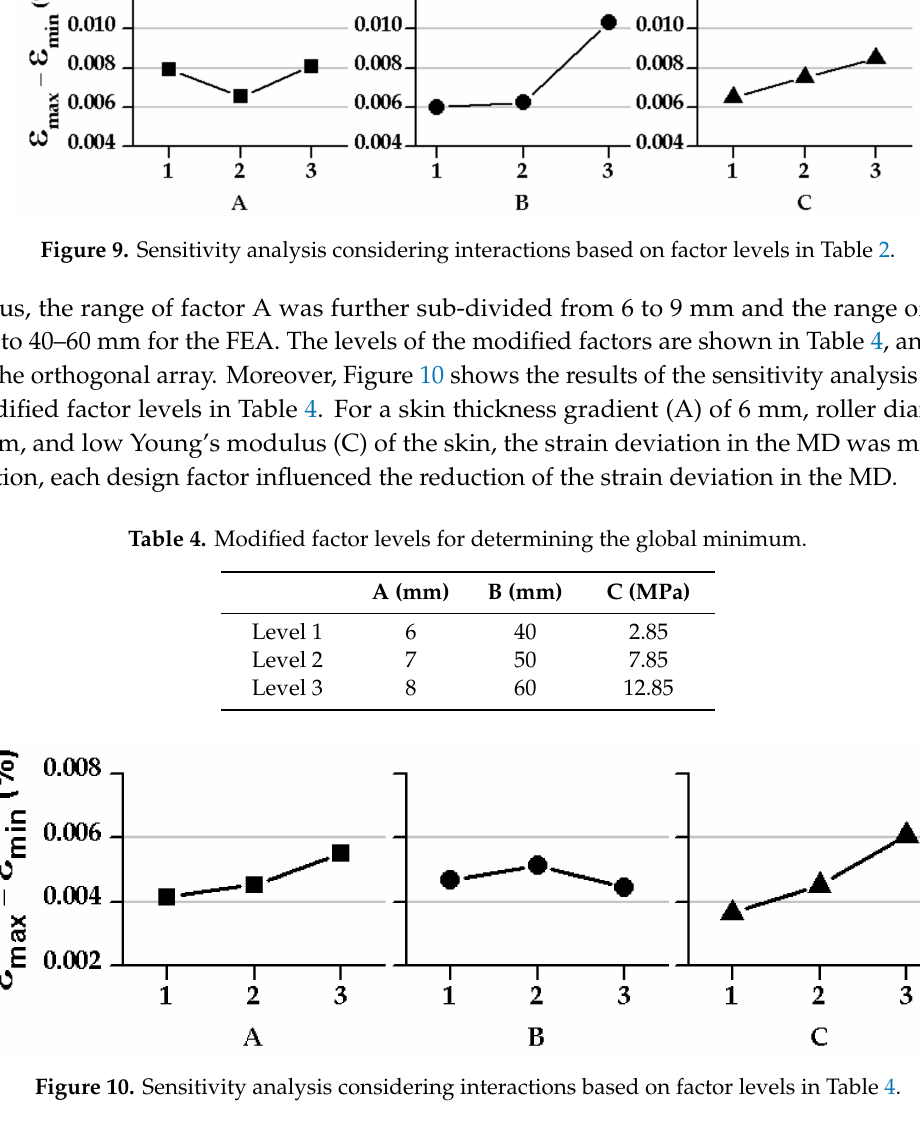
Figure 10. Sensitivity analysis considering interactions based on factor levels in Table